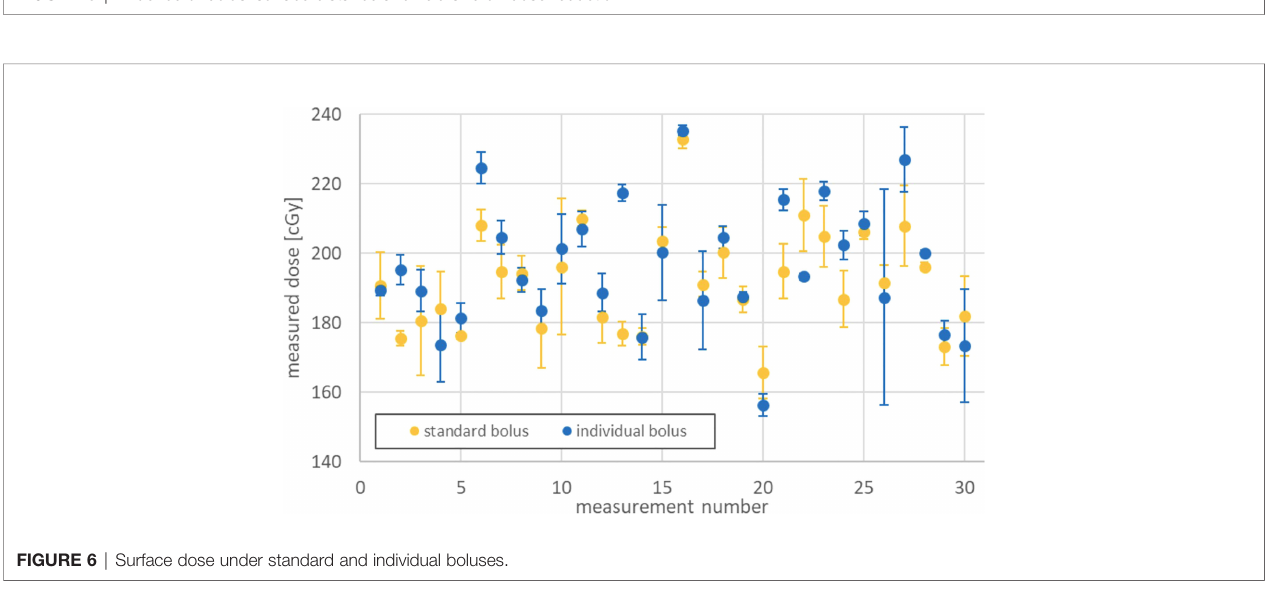
FIGURE 5 | In fl uence of bolus – surface distance and fi eld size on dose reduction.